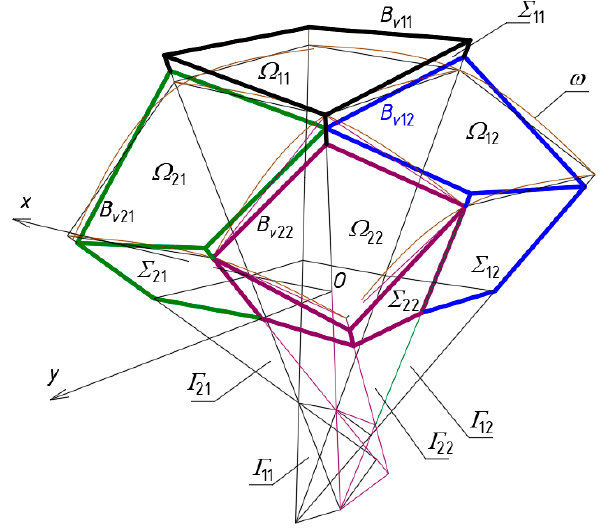
Figure 4. A free-form building structure roofed with a regular discontinuous shell structure charac- terized by the positive Gaussian curvature.